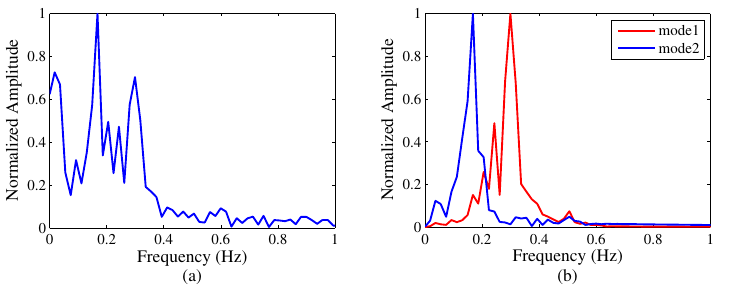
Figure 7. The comparison of the traditional FFT method and VMD based method. ( a ) FFT results without VMD based algorithm; ( b ) FFT results with VMD based algorithm.